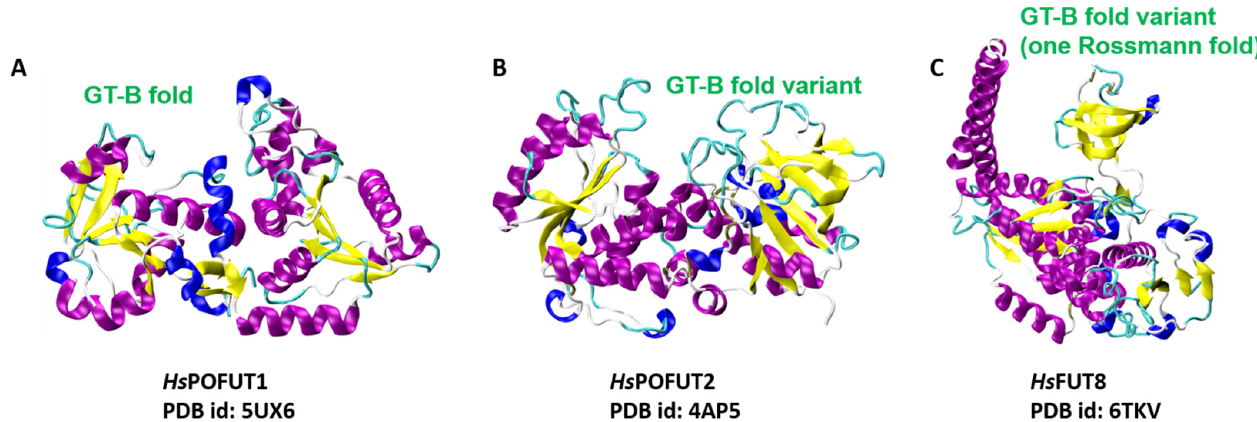
Figure 5. Representative glycosyltransferase with GT-B global fold and its variants. ( A ) GT-B fold corresponding to Hs POFUT1 (PDB id: 5UX6). ( B ) GT-B fold variant corresponding to Hs POFUT2 (PDB id: 4AP5). ( C ) GT-B fold variant with a single Rossmann fold corresponding to Hs FUTV8 (PDB id: 6TKV).